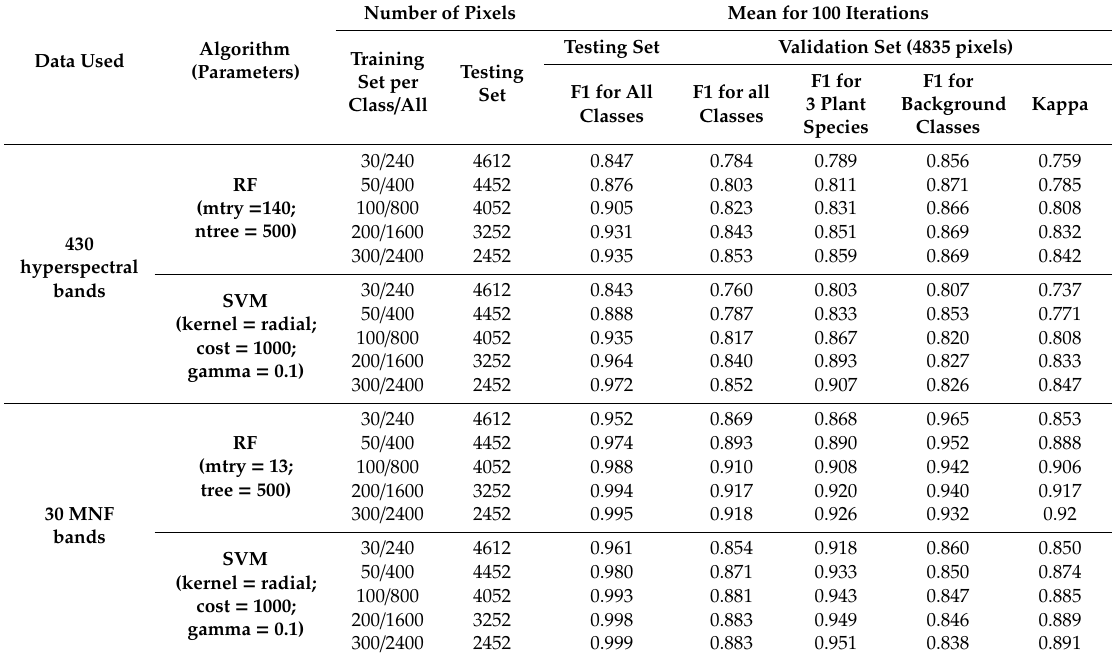
Table 2. Classifier training parameters and their average F1